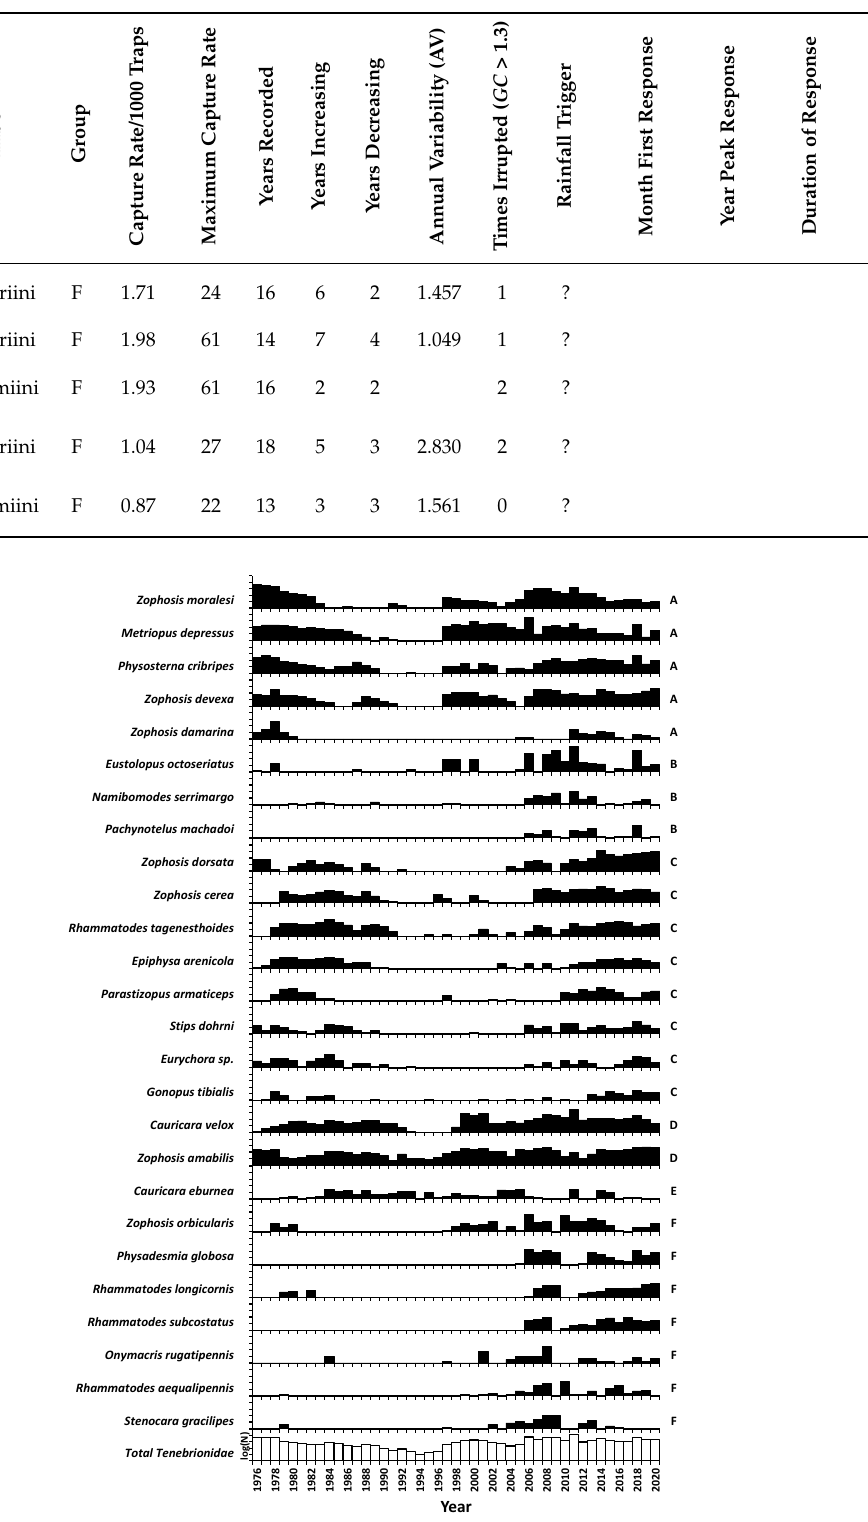
Figure 6. Time series of the standardised annual abundance of focal species on the gravel plain. Members of groups A–F correlate (r = 0.47–0.89, p < 0.001) with other group members and are linked with cluster analysis.